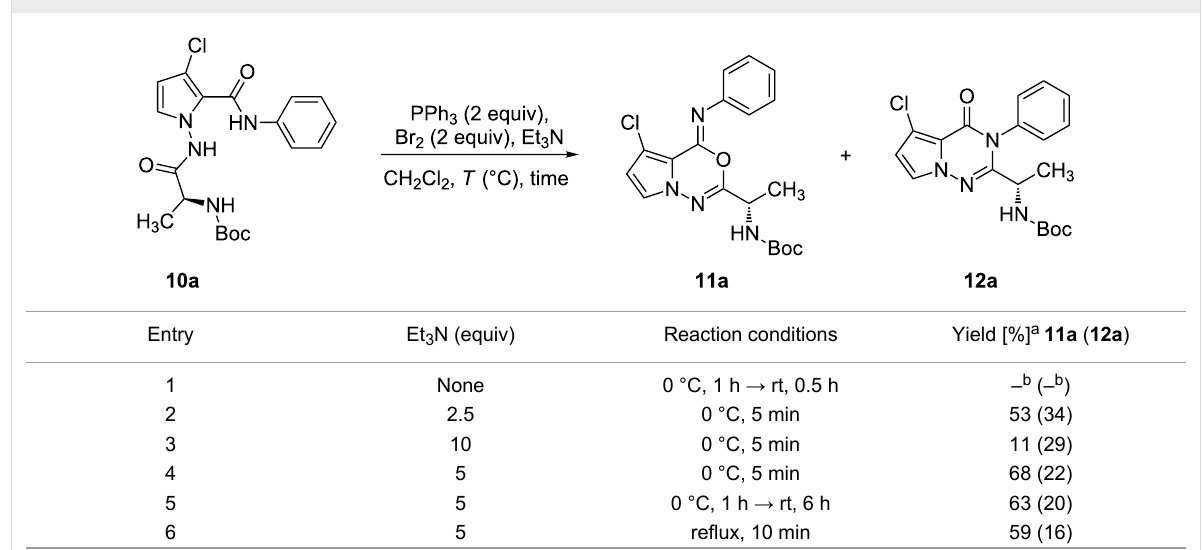
(Table 2). For nucleophile-induced cyclization, pyrrolidine, Li(Me 3 AlSPh) [22], NaSMe, and NaOMe were